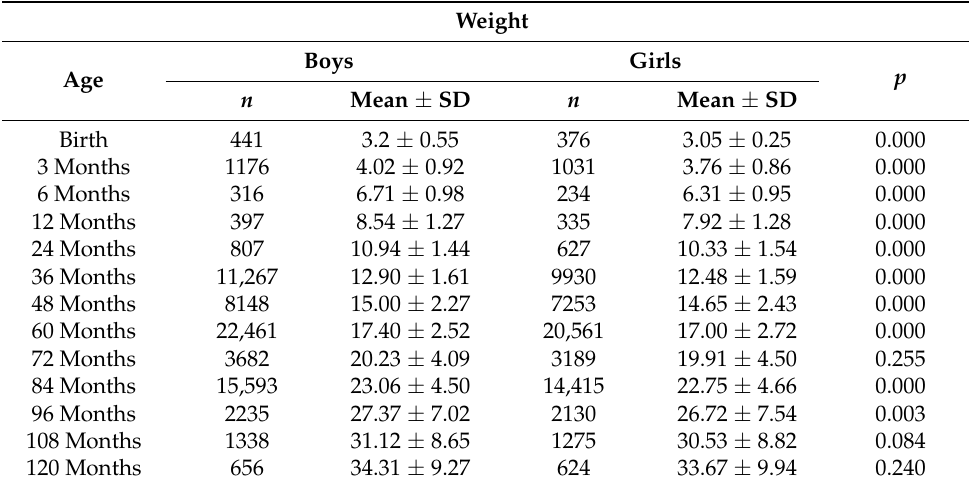
Table 4. Weight (kg) comparisons between boys and girls by age.